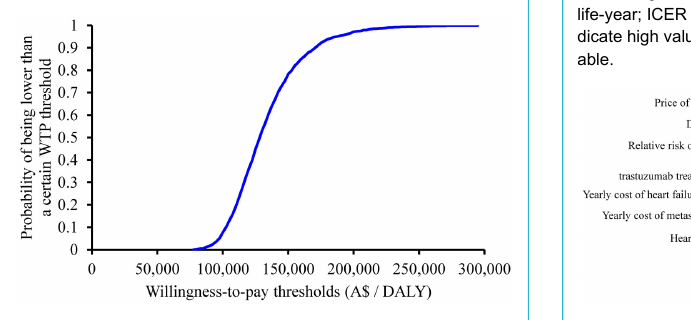
Figure 4: The cost-effectiveness acceptability curve. DALY = dis- ability-adjusted life-year; WTP = willingness-to-pay.